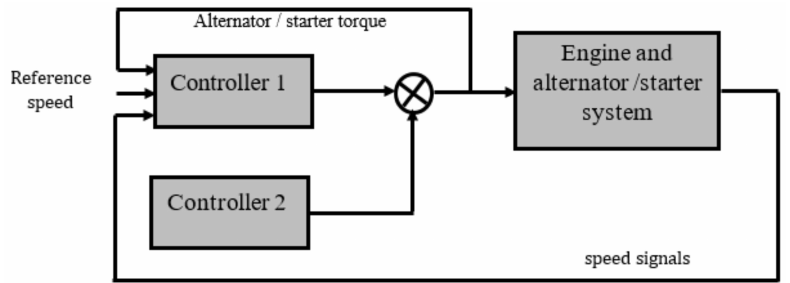
Figure 13. MPC block diagram for the BSA “Reprinted from [17]”.